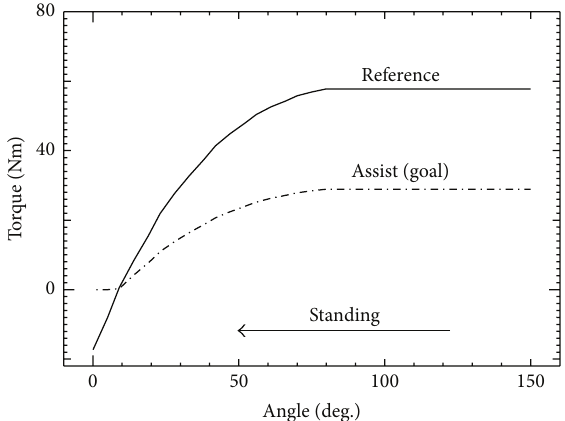
Figure 3: Natural standing torque and assisted torque around the knee joint (original data of solid line are obtained from